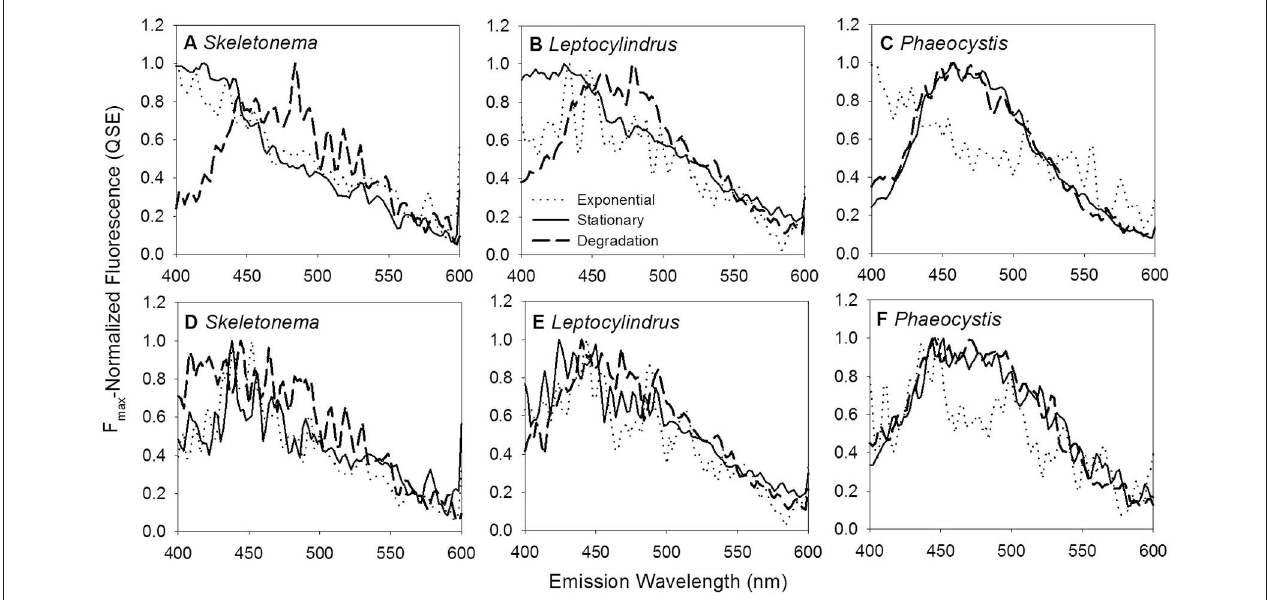
FIGURE 3 | BEPOM (A–C) and CDOM (D–F) F max -normalized emission spectra at 250nm excitation for genera Skeletonema , Leptocylindrus , and Phaeocystis at exponential (dotted line), stationary (solid line), and degradation (dashed line) growth phases.